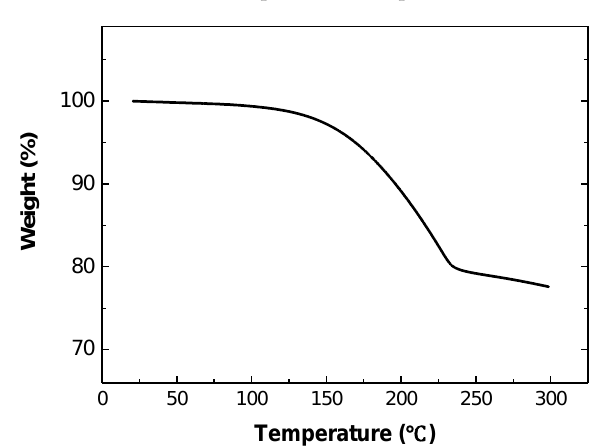
Figure 3. XRD pattern of Cu powders.